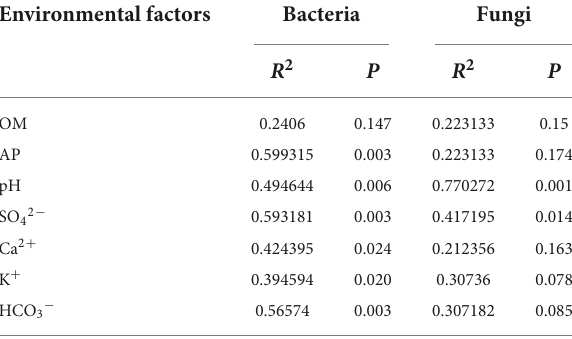
TABLE 5 Significance of the soil physicochemical properties in explaining the community structure obtained from the RDA results. Environmental factors